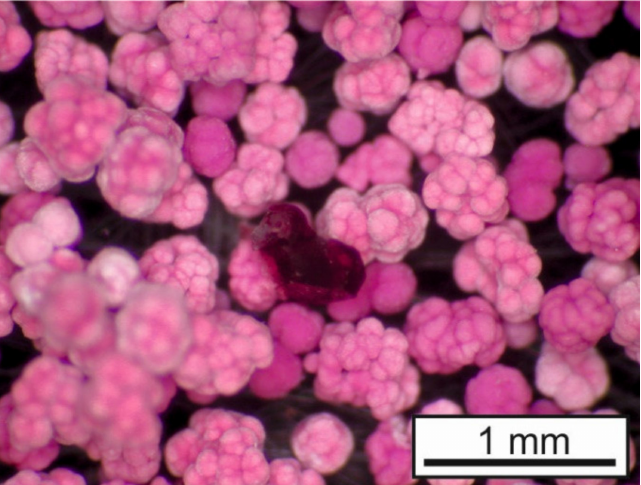
Figure 18. Single crystal of erythrite formed after primary erythrite lumps due to a secondary pH increase in gel by the use of a 2.5% NH 4 OH